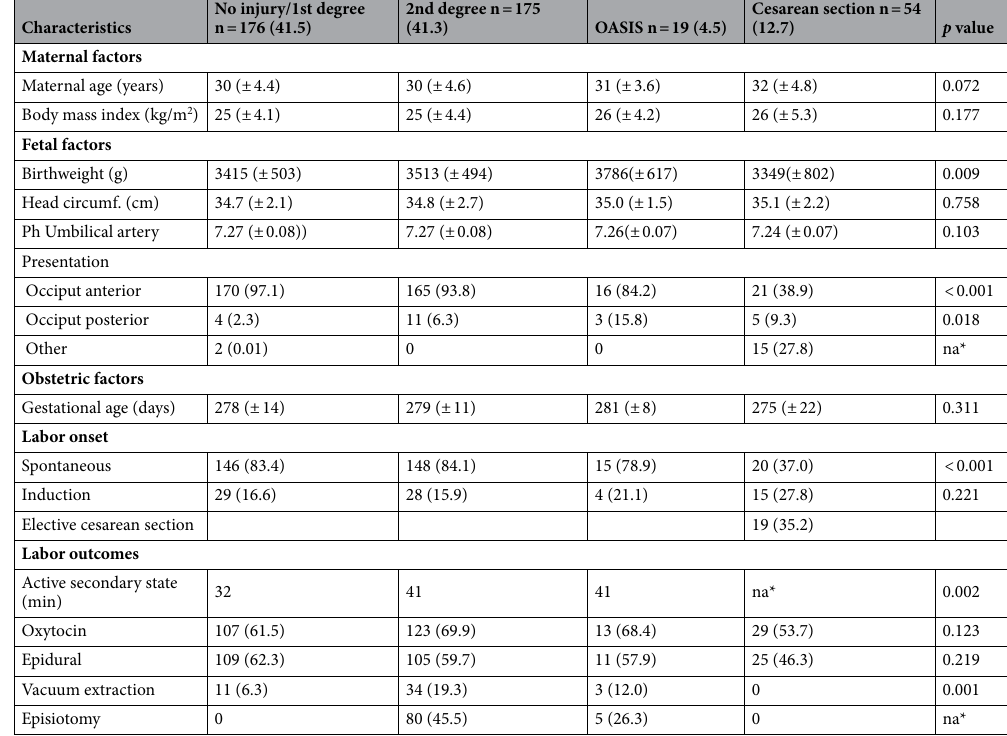
Table 2. Demographic and obstetric characteristics of analyzed responders in the three different groups of perineal trauma and cesarean section. Data are the mean ± SD or n (%). *na = not